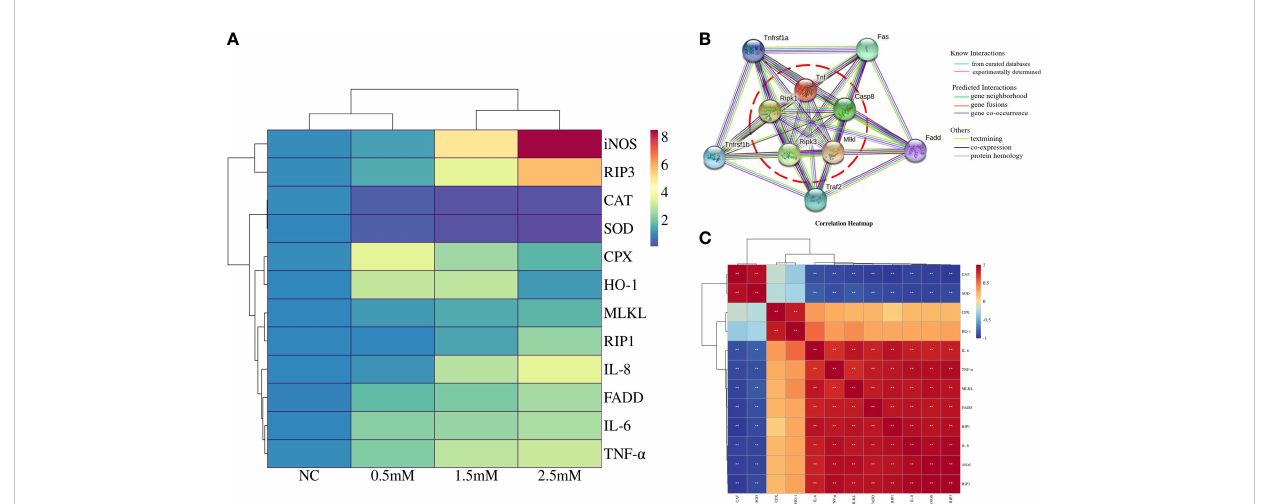
FIGURE 4 (A) Correlation heatmap indicates correlation of detected gene expression in spleen lymphocytes exposed to different concentrations of NiCl indicates positive correlation and blue indicates negative correlation. (B) Protein-protein interaction (PPI) network regulated between antioxidative enzymes genes, in fl ammation, and necroptosis based on the String database in spleen lymphocytes exposed to different concentrations of NiCl 2 . (C) Heatmap of cluster analysis in spleen lymphocytes exposed to different concentrations of NiCl 2 . Blue represents downregulated while red represents